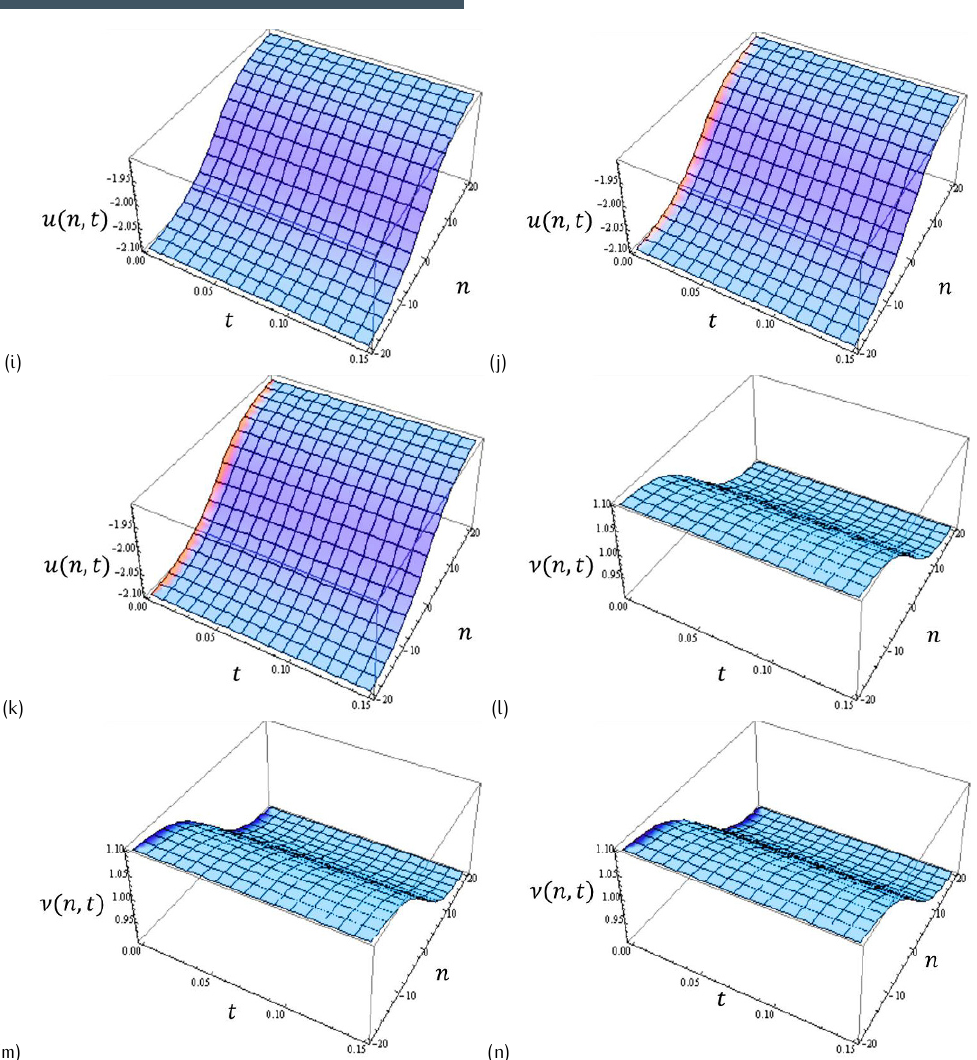
Figure 9. Explicit numerical solutions of Eq. (42) for u numerical solutions of Eq. (43) for as in (66) at (l) µ = 1 , λ = 1 ; (m) µ = 1